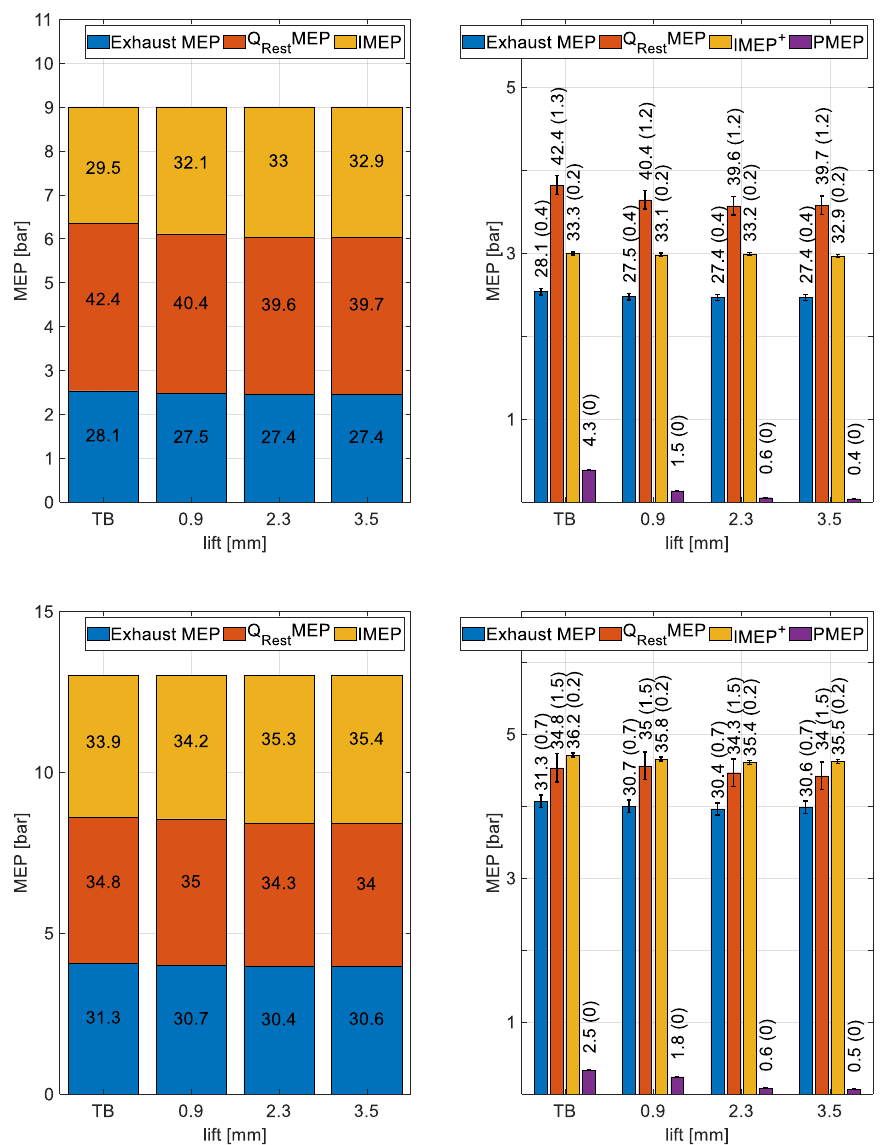
Figure 10. Energy balance at 9 bar (above) and 13 bar (below) FuelMEP for throttled (TB) operation and three levels of valve lift (three values of IVC).